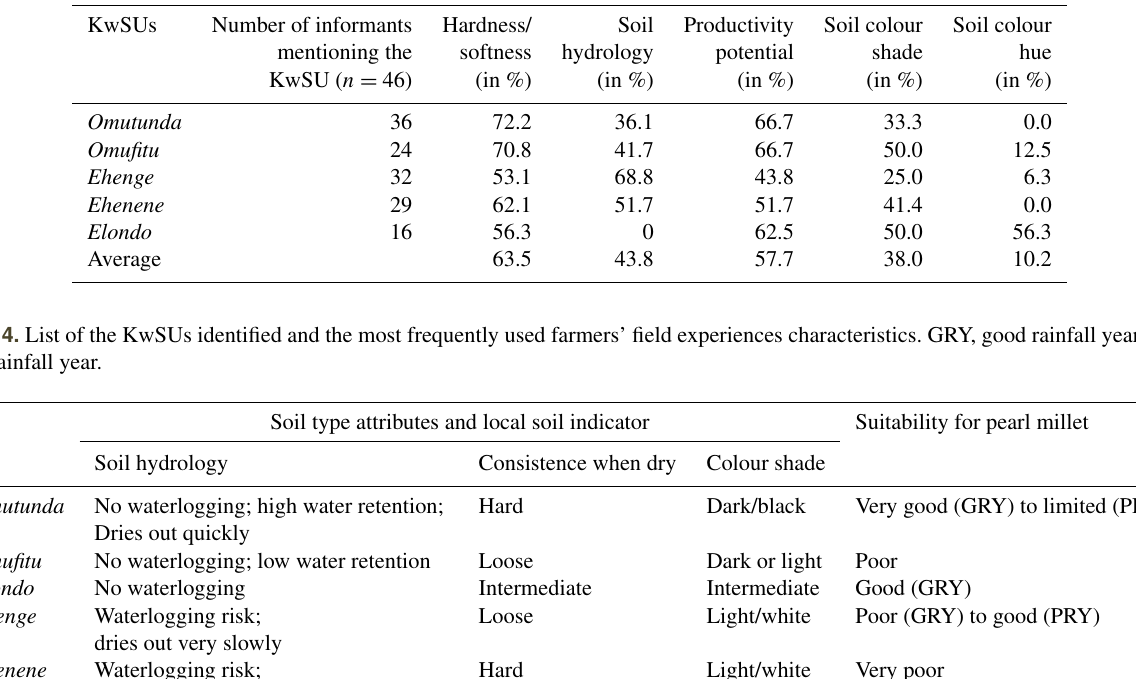
Table 3. List of farmers’ field experience (FFE) characteristics used to describe each KwSU, with the number of informants mentioning each KwSU ( n ) and the proportion of informants mentioning each characteristic (in relation to n ). Values are only indicative as the data collection method was not adapted for quantitative analyses.